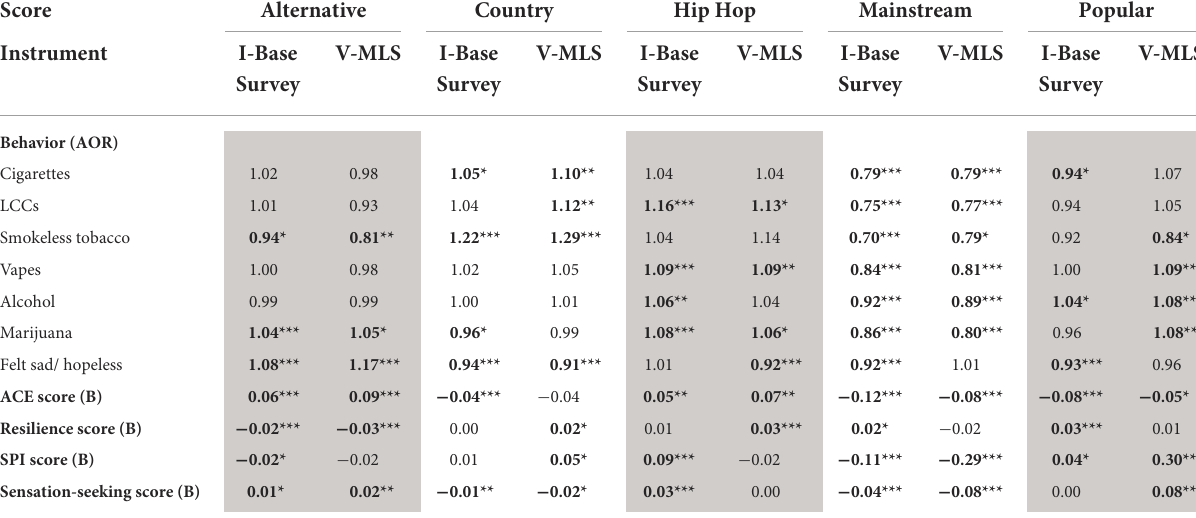
TABLE 4 Peer crowd scores as predictors of behavior, experiences, and personal